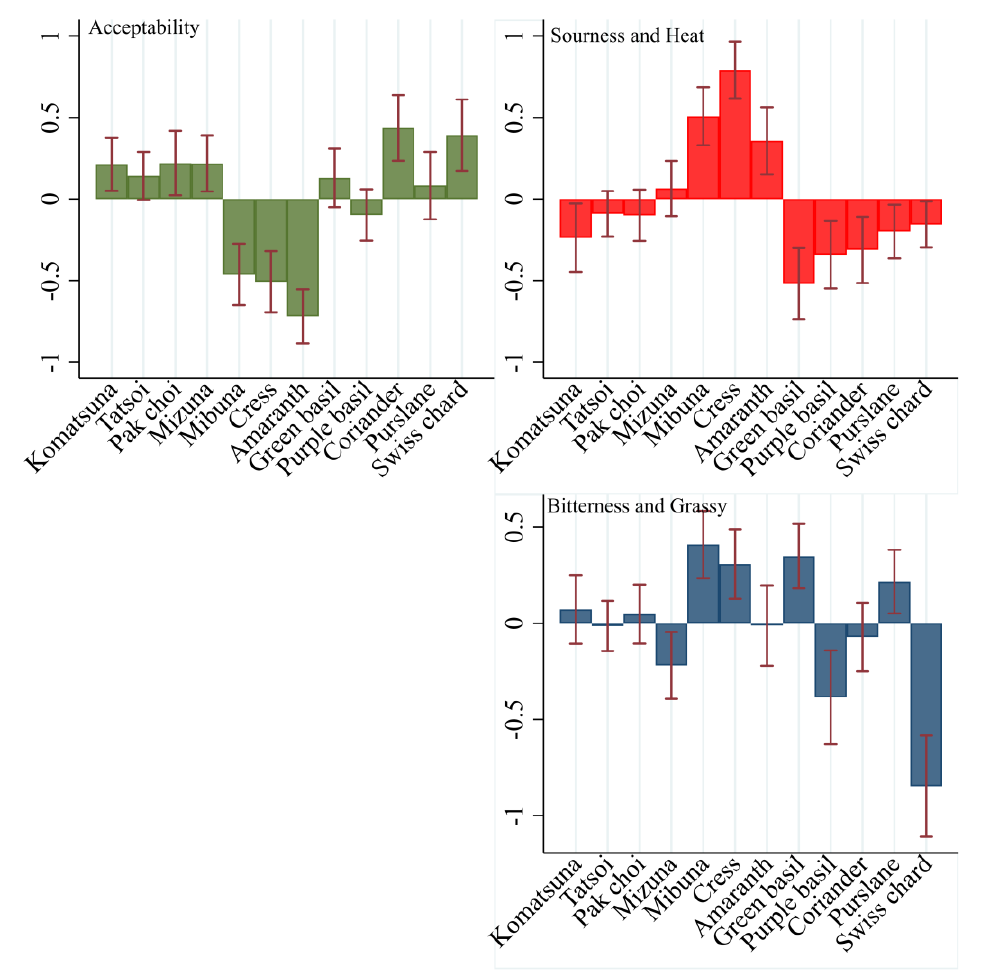
Figure 3. Mean and the 95% confidence intervals of the three latent constructs (Acceptability; Bitterness and Grassy; Sourness and Heat) for the 12 microgreens species as calculated by PLS-SEM. All latent constructs are standardized with a mean of 0 and a standard deviation of 1. Swiss chard and coriander scored the higher level of acceptability while for almost all the considered microgreens, a higher (lower) value of acceptability is associated to a lower (higher) value of “Sourness and Heat”.